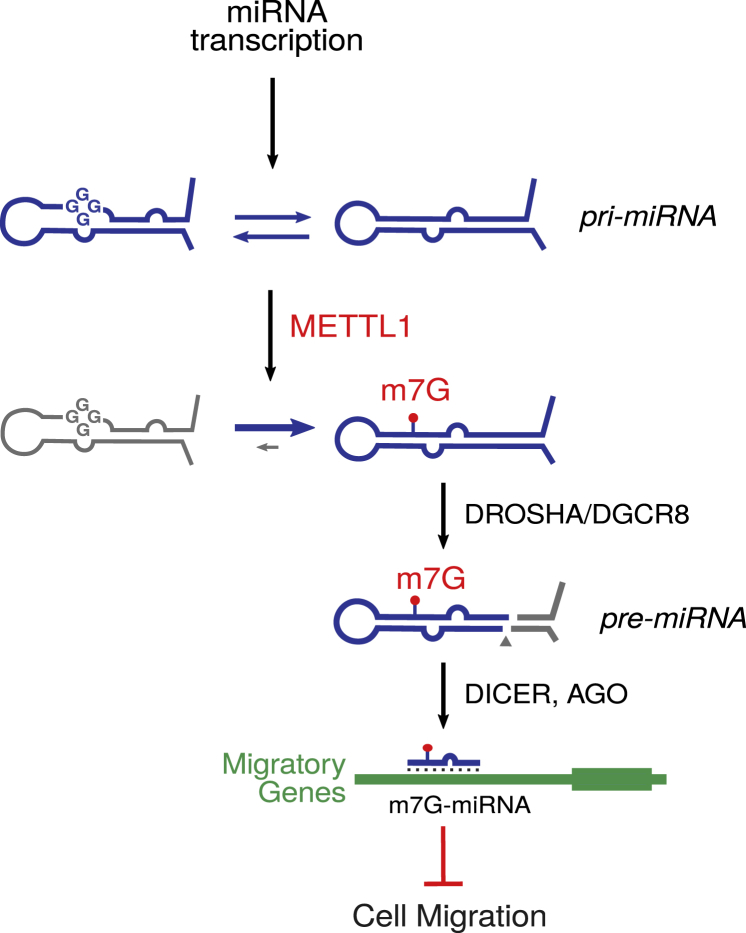
Role of m7G in miRNA BiogenesisProposed model of the role of METTL1-mediated m7G in promoting miRNA processing and suppressing migration phenotype.